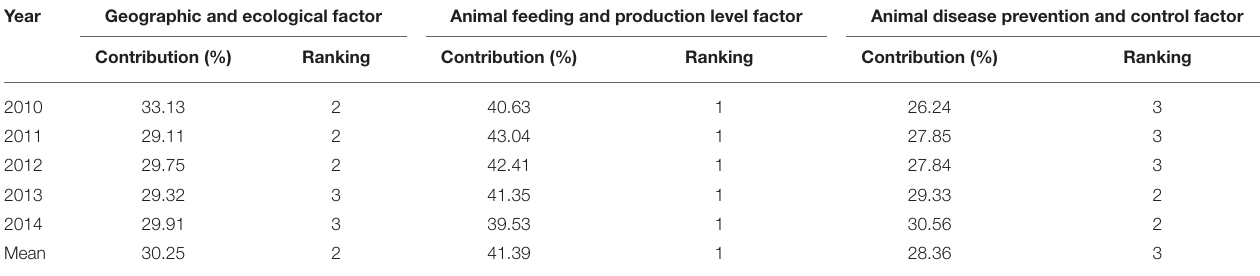
TABLE 5 | Decomposition of interregional differences in animal disease